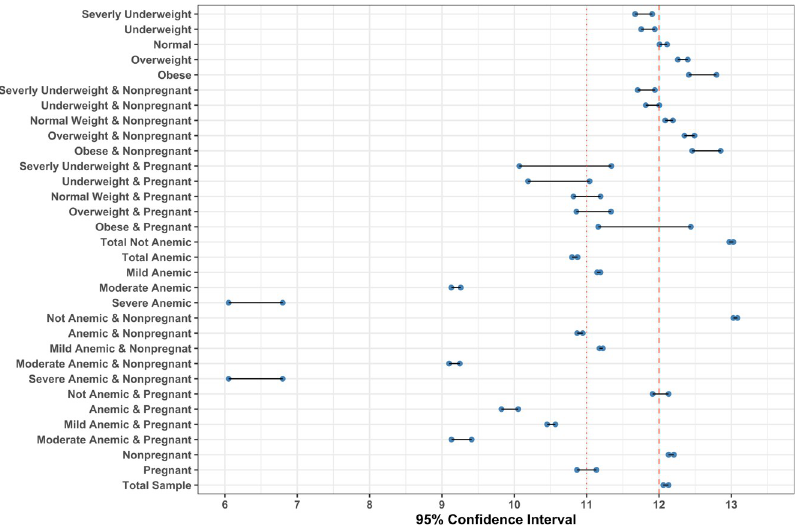
Fig 5. Forest plot of 95% CI of blood hemoglobin level of women (n = 5680) of different BMI and anemia group (vertical lines are anemia cut-off point [red dotted line at 11 gm/dl]).